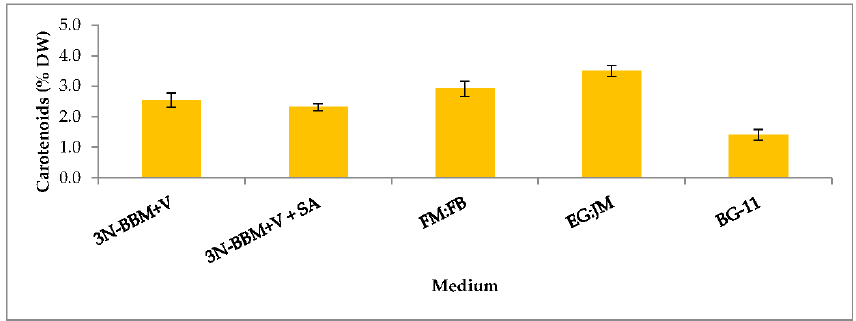
Figure 7. Carotenoid content (% DW) in H. pluvialis cultivated in a range of autotropic and mixotrophic media. Mean carotenoid content (% DW) ± S.D. ( n = 3). Re-suspension of cultures in green stage grown in various autotrophic and mixotrophic media (10 days) in red stage induction conditions for 12 days in medium without nitrate (20 °C, continuous light at 240 µmol photons m − 2 ·s − 1 ).